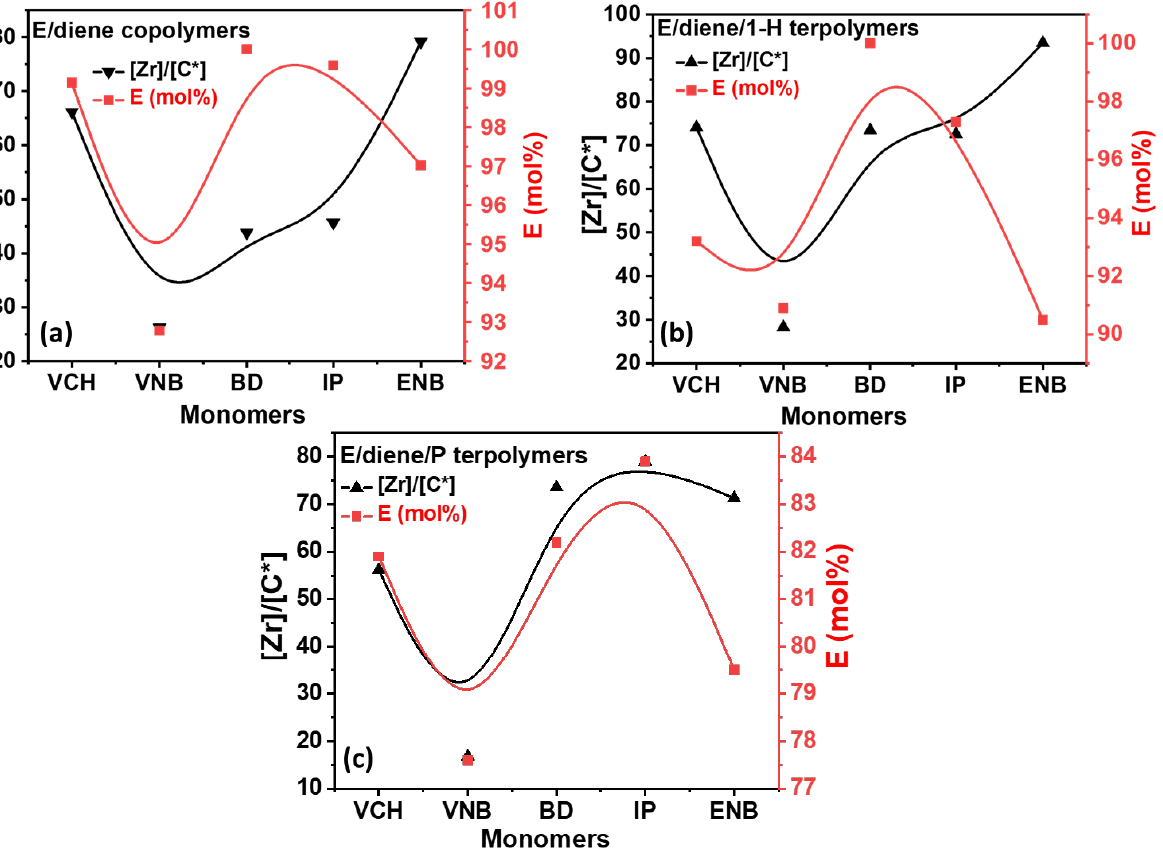
Figure 4. ( a ) Comparison between active centers and ethylene mole% in E/diene copolymers; ( b , c ) comparison of active centers and ethylene mole% in E/diene/1-hexene and E/diene/P